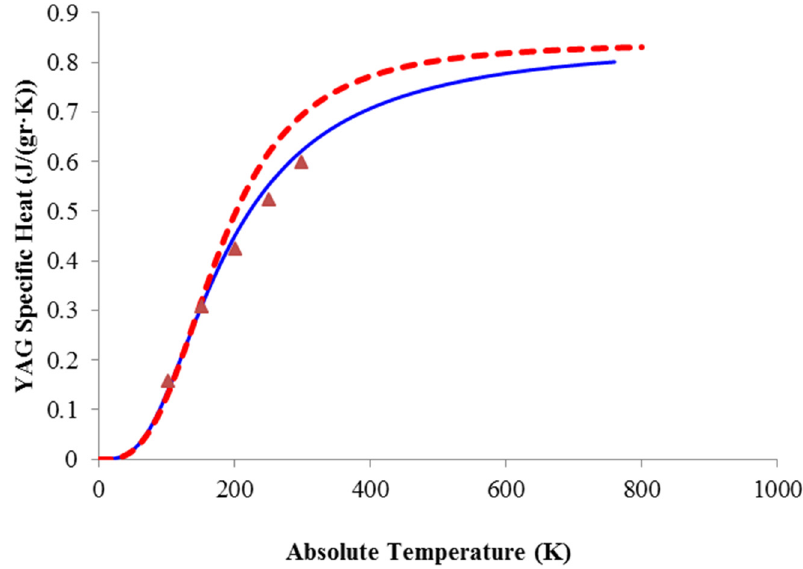
Figure 3. Specific heat for the undoped laser material Y 3 Al 5 O 12 as a function of temperature. Shown are the calculated values (solid blue line) using Equation (32), the values obtained with the specific heat approximation of Equation (34) (dashed red line), and the experimental data from [29].